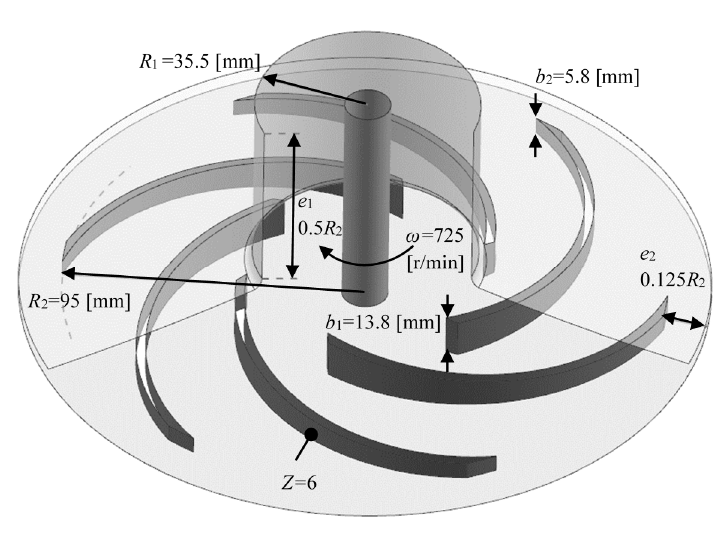
Figure 2. Schematic map of the pump impeller object.